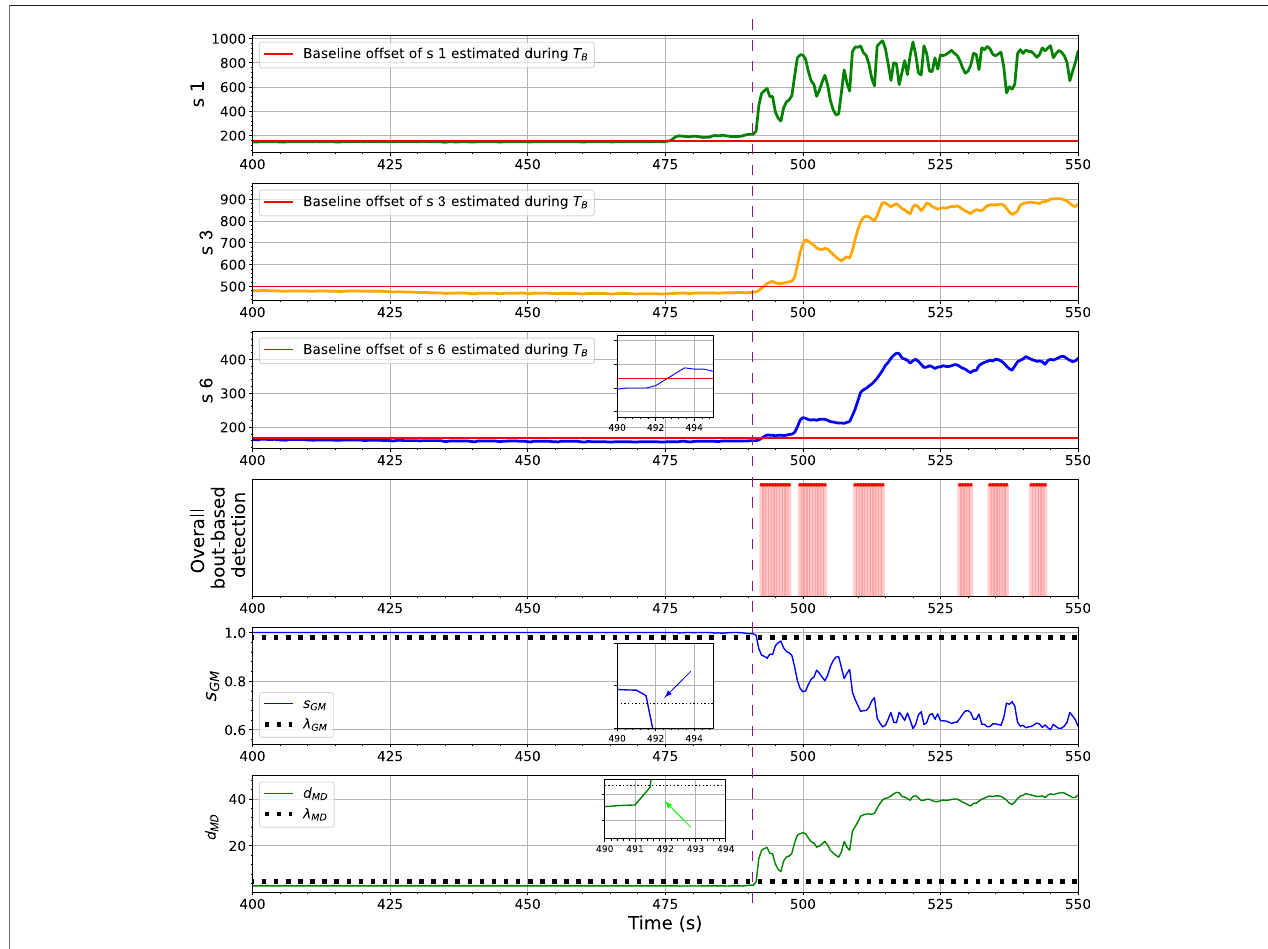
FIGURE 14 | The changes of ORU nose sensor responses, s GM , d MD and the BCD model output towards the fi rst gas exposure in the Exp. 3-source trial. The vertical purple dashed line locates the time point where s GM and d MD presented signi fi cant indications of gas detection (as pointed by corresponding arrows) when sensorresponsesof s 2and s 3arestillbelowtheirbaselineoffsetvalues.Onecanclearly observethatat t =492s, s GM and d MD aretheirthresholdswhilethevaluesof s 2 and s 3 are below their corresponding baseline